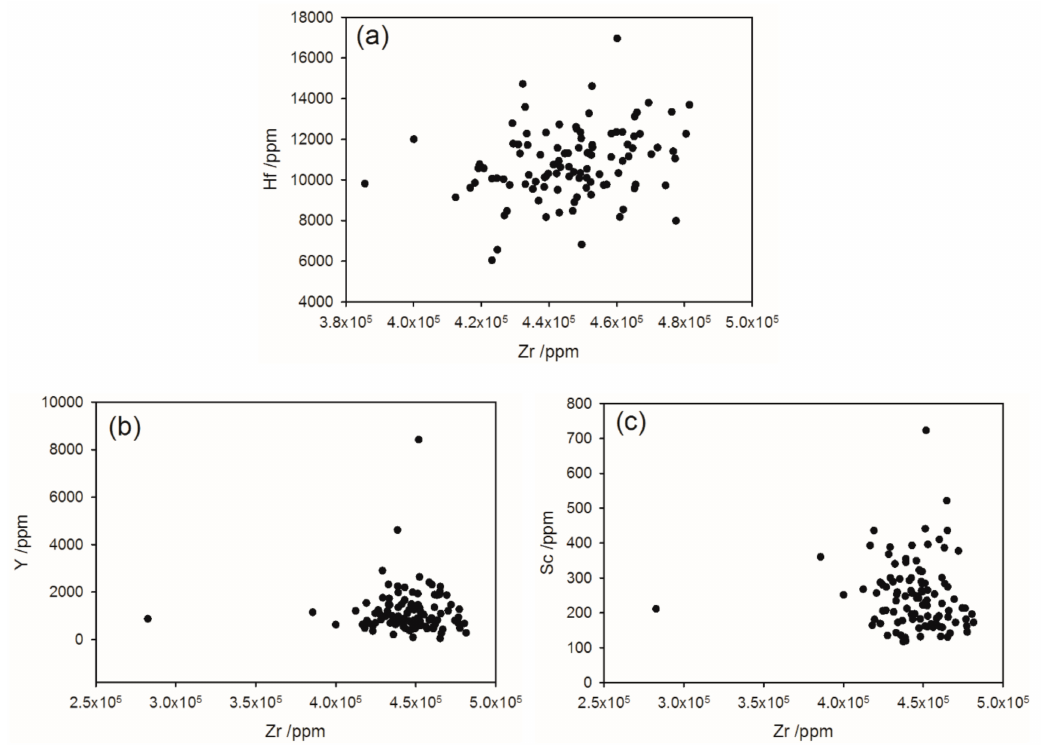
Figure 7. Zircon analysis with the correlation between Zr and ( a ) Hf; ( b ) Y, ( c ) Sc.